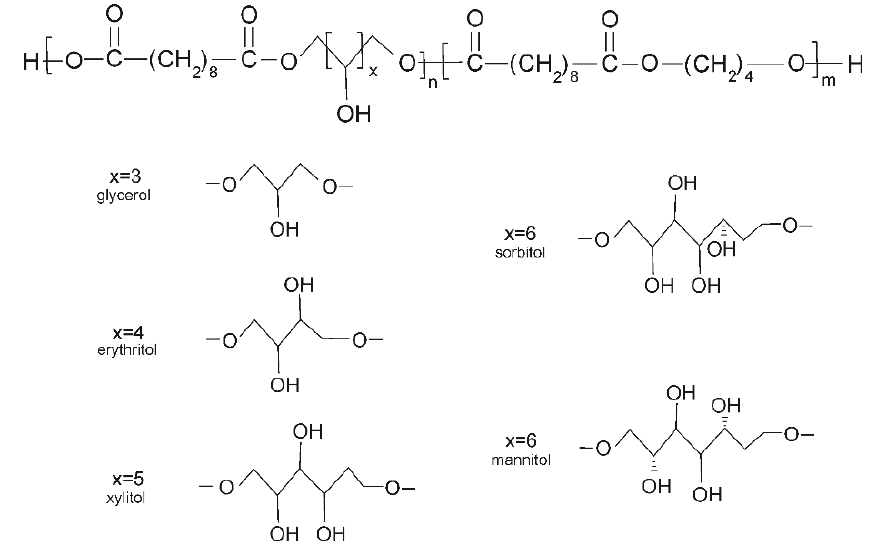
Figure 1. Scheme of of poly(polyol sebacate-co-butylene sebacate) structure.